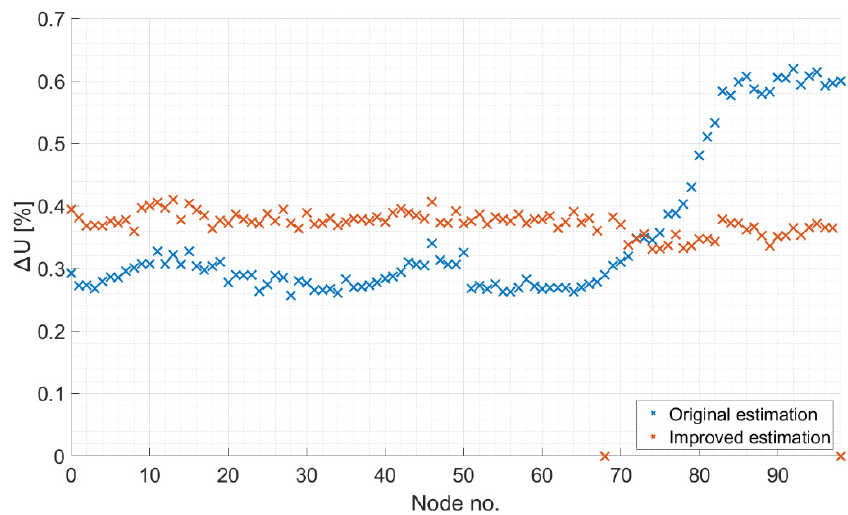
Figure 8. Average relative error of voltages for Area 44,600.